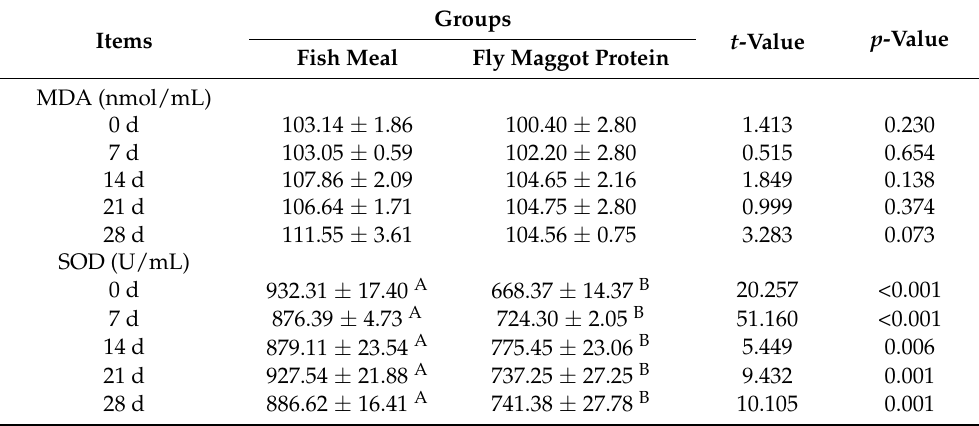
Table 5. Effects of different protein sources in place of fish meal on serum antioxidant indexes of weaned blue